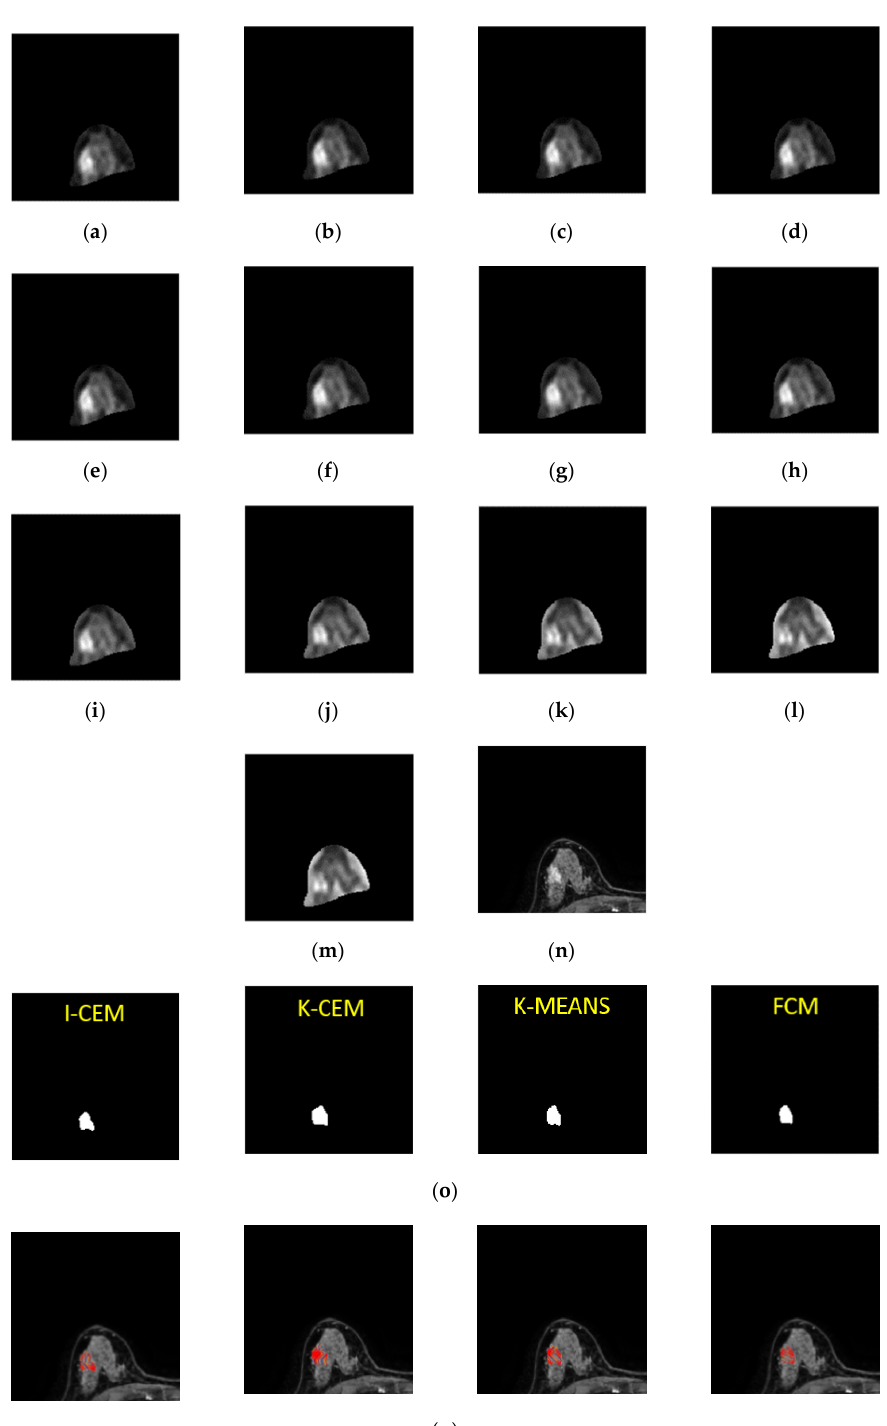
Figure 11. Eighth-slice IVIM-DW images of a non-mass tumor with b -values of ( a ) 0, ( b ) 15, ( c ) 30, ( d ) 45, ( e ) 60, ( f ) 100, ( g ) 200, ( h ) 400, ( i ) 600, ( j ) 1000, ( k ) 1500, ( l ) 2000, and ( m ) 2500 s/mm 2 . ( n ) Dynamic contrast-enhanced T1-MR imaging. ( o ) Tumor detection results obtained via I-CEM, K-CEM, K-means, and FCM methods. ( p ) Tumors obtained via the four methods (left-to-right: I-CEM, K-CEM, K-means, and FCM) mapped onto a dynamic contrast-enhanced T1-MR image.